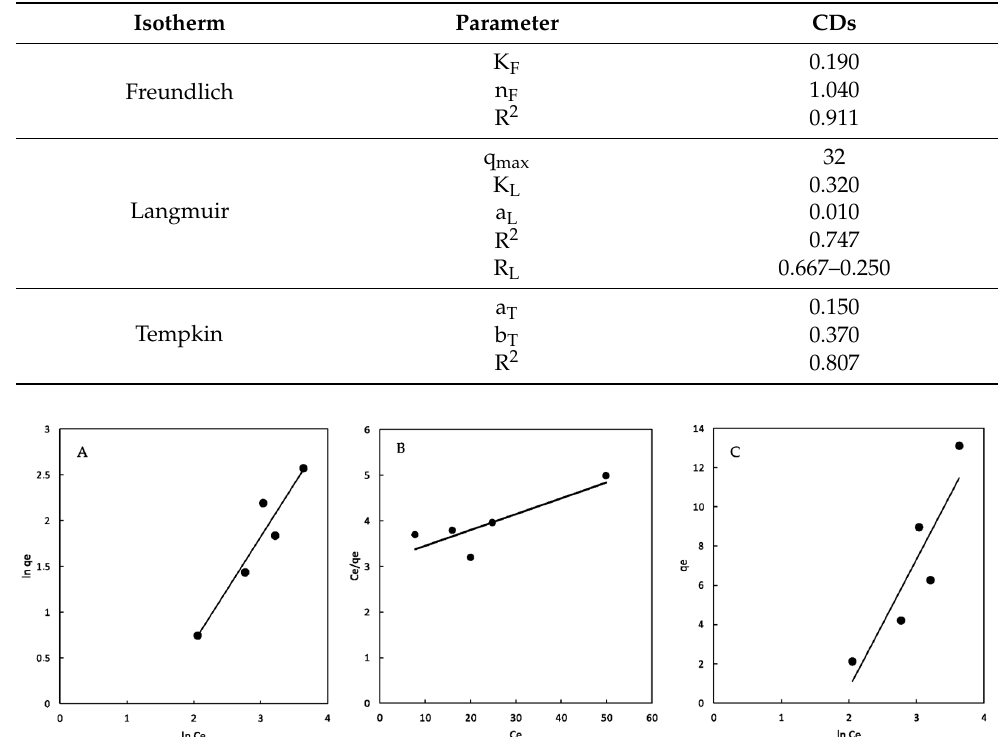
Table 2. The isotherm results for the Freundlich, Langmuir, and Tempkin models.